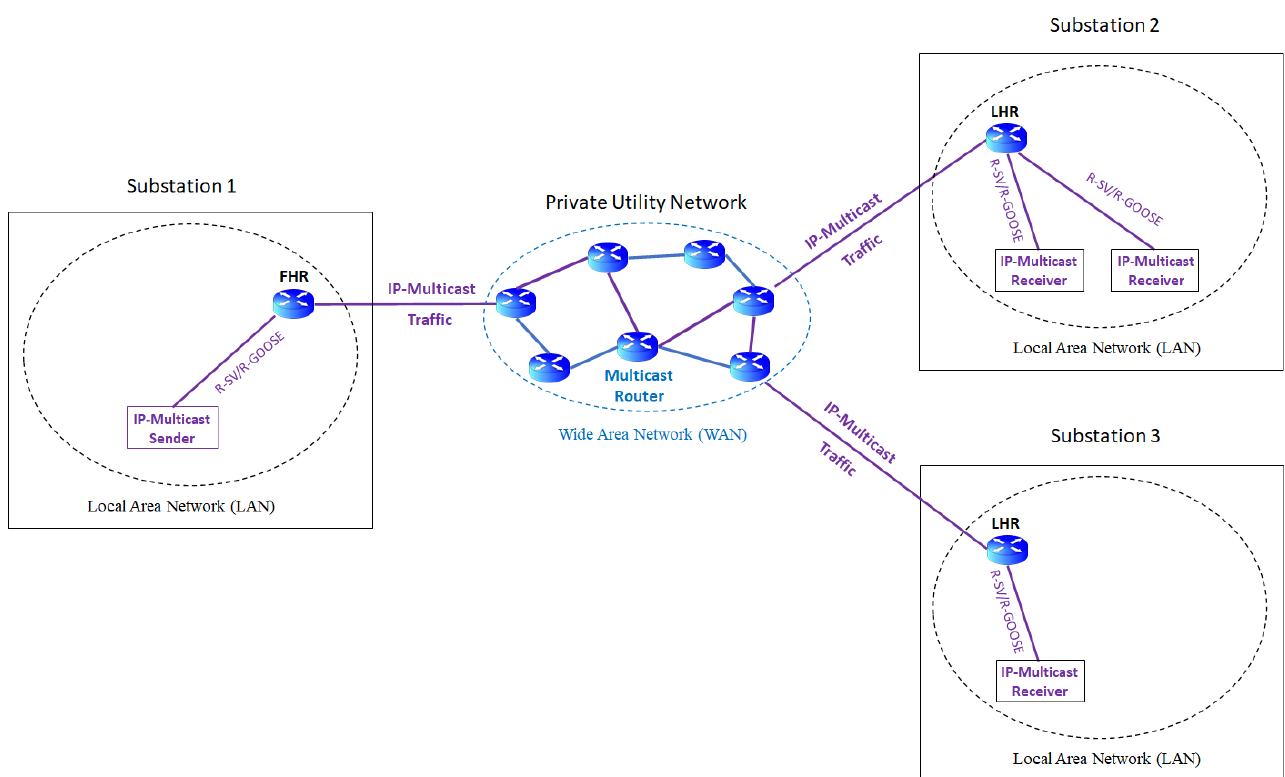
Figure 5. IP-Multicast communication from Substation 1 to Substation 2 and 3 via private utility network.